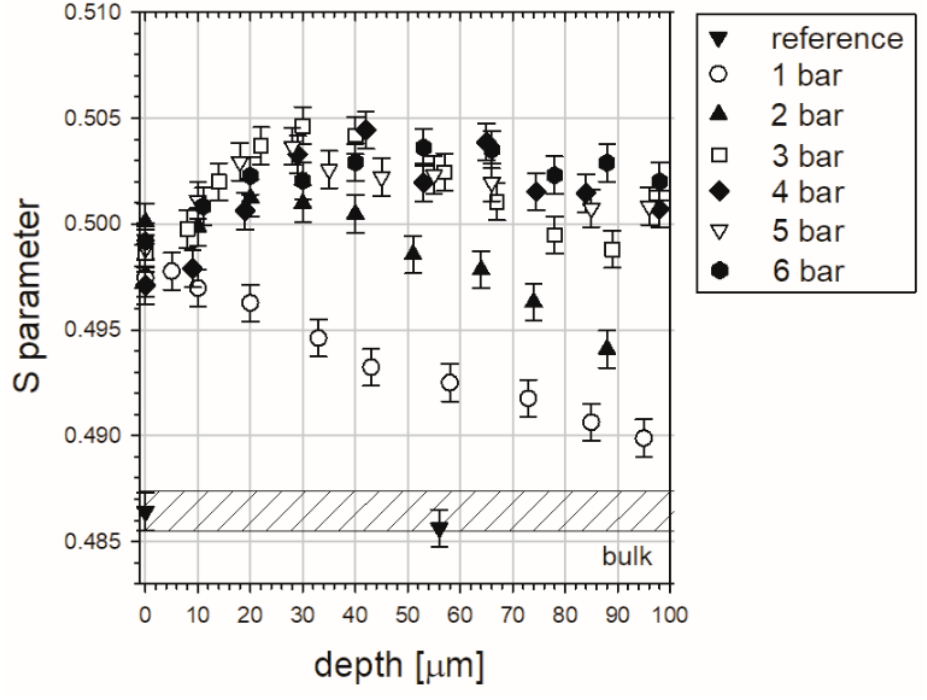
Figure 9. S parameter dependent on the depth in the range 0–100 µm for the well-annealed copper samples sandblasted with alumina particles at different pressures.